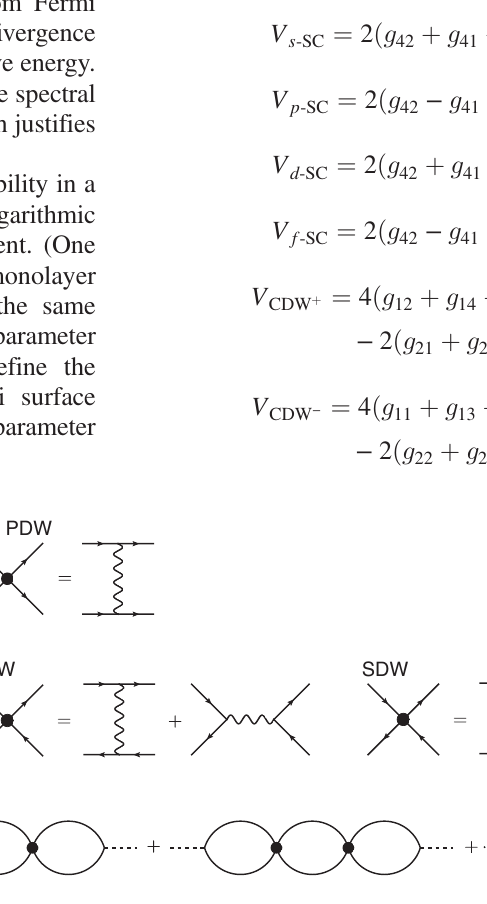
FIG. 8. Diagrammatic representation of interactions and summation for the susceptibility. (a) Diagrams for interactions in the particle- particle channel V pp and in the particle-hole channel V ph . The two-particle interactions are drawn by four-leg ladders. (b) Interactions for various orderings to the lowest order. (c) RPA-like resummation for